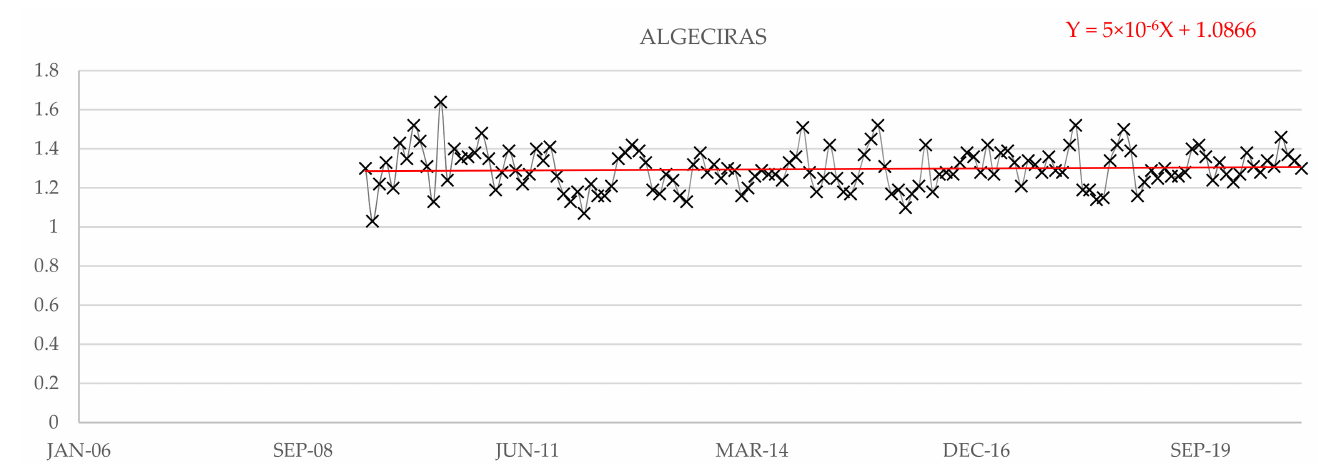
Figure 34. Evolution of SL maxima in